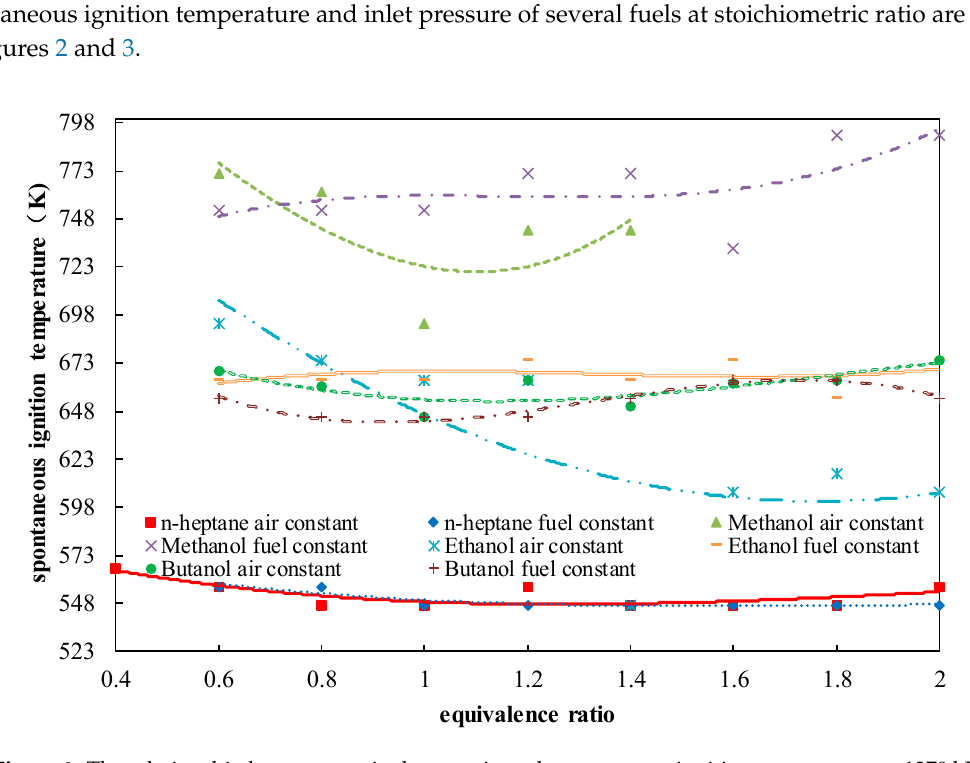
Figure 2. The relationship between equivalence ratio and spontaneous ignition temperature at 1379 kPa, 473 K.